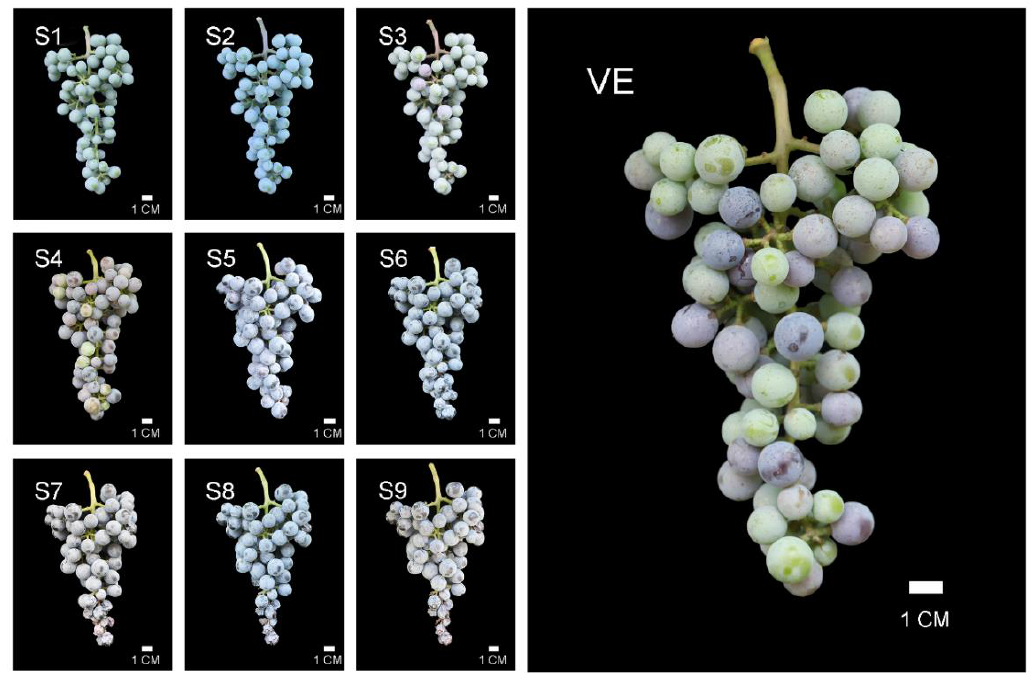
Figure A3. Photos of ‘Beixin’ were taken during sampling time in 2019. S1–S9 represent the sampling date in 2019, and bar = 1 cm.